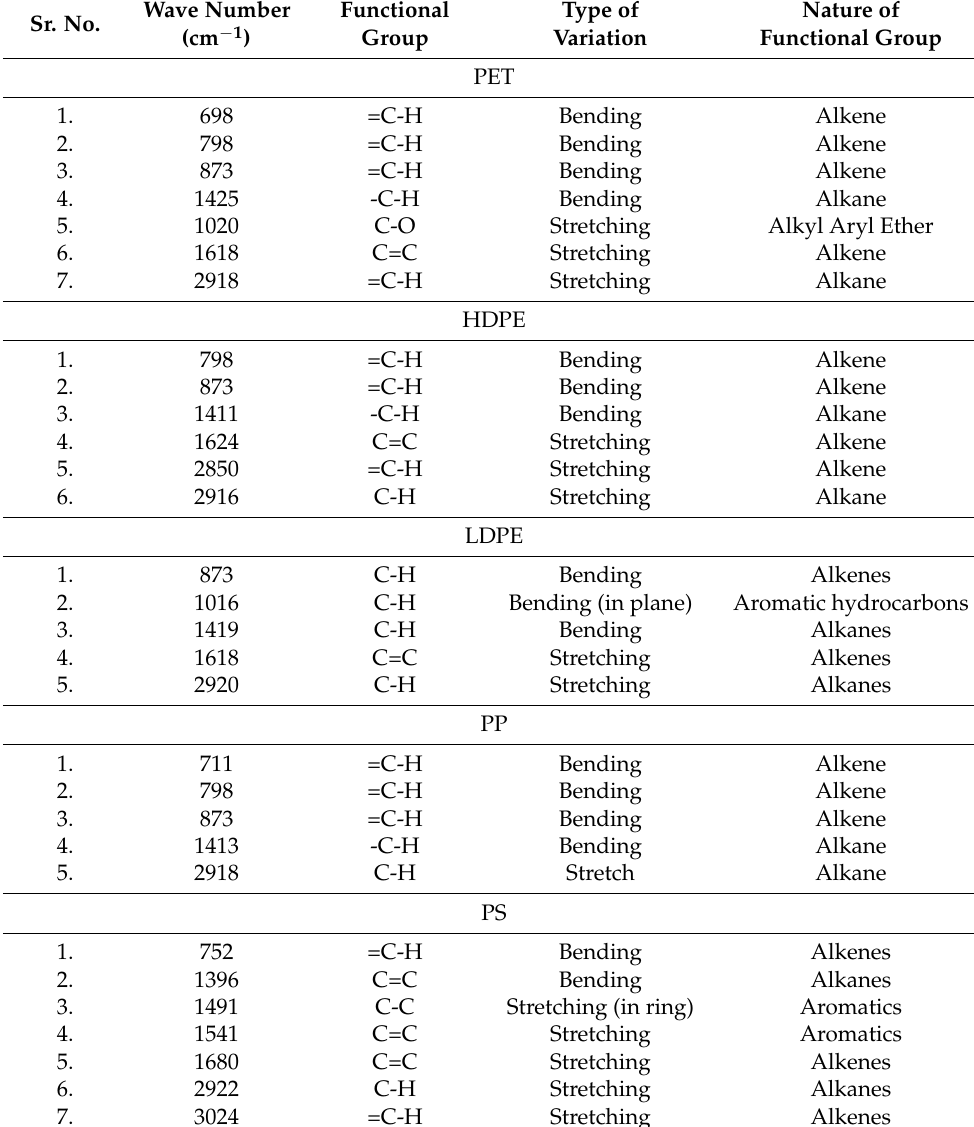
Table 3. FT-IR assignment for the derived fuel